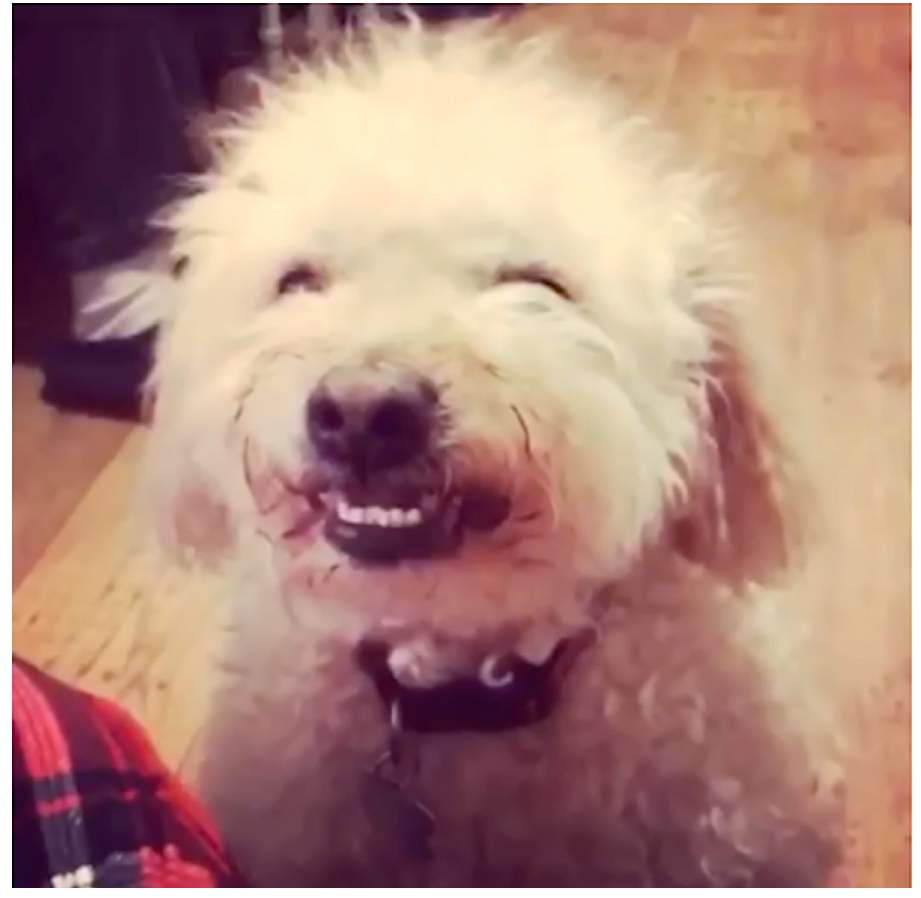
Fig 6. Screenshot of video from dog owner. Illustrates an expression that the owner perceives as